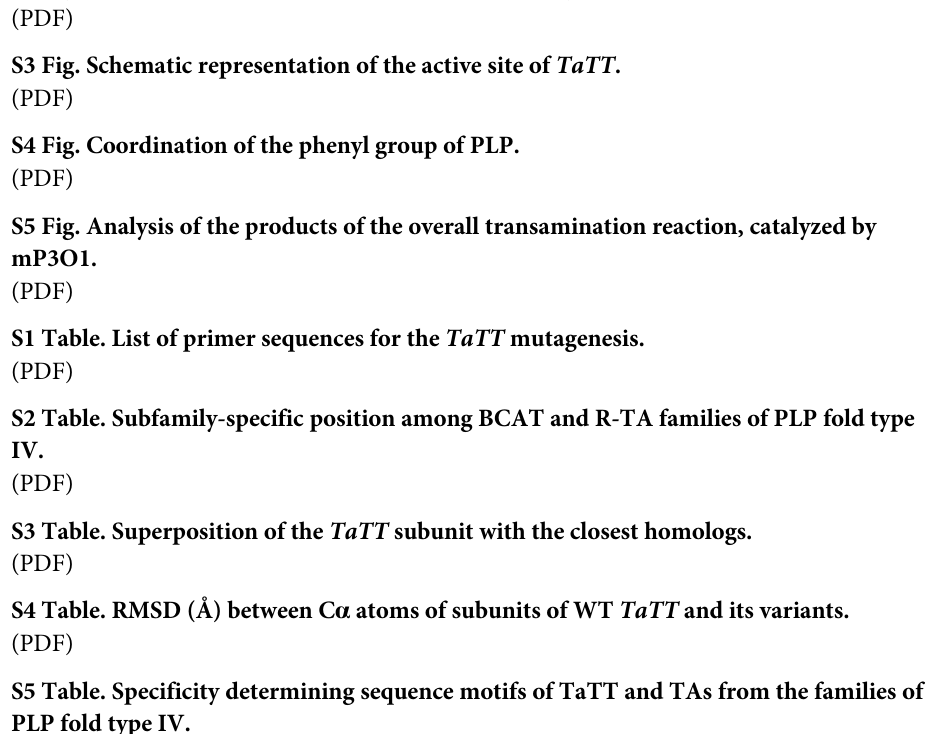
S2 Fig. The active site of PLP-dependent TAs of fold type IV. (PDF) S3 Fig. Schematic representation of the active site of TaTT . (PDF) S4 Fig. Coordination of the phenyl group of PLP. (PDF) S5 Fig. Analysis of the products of the overall transamination reaction, catalyzed by mP3O1. (PDF) S1 Table. List of primer sequences for the TaTT mutagenesis. (PDF) S2 Table. Subfamily-specific position among BCAT and R-TA families of PLP fold type IV. (PDF) S3 Table. Superposition of the TaTT subunit with the closest homologs. (PDF) S4 Table. RMSD ( Å ) between C α atoms of subunits of WT TaTT and its variants. (PDF) S5 Table. Specificity determining sequence motifs of TaTT and TAs from the families of PLP fold type IV. S1 File. Determination of the initial activity of TaTT and its variants in the overall reac- tion. (PDF) S2 File. Determination of the melting temperature of TaTT and its variants. (PDF) S3 File. Analysis of half-reactions of TaTT and its variants.